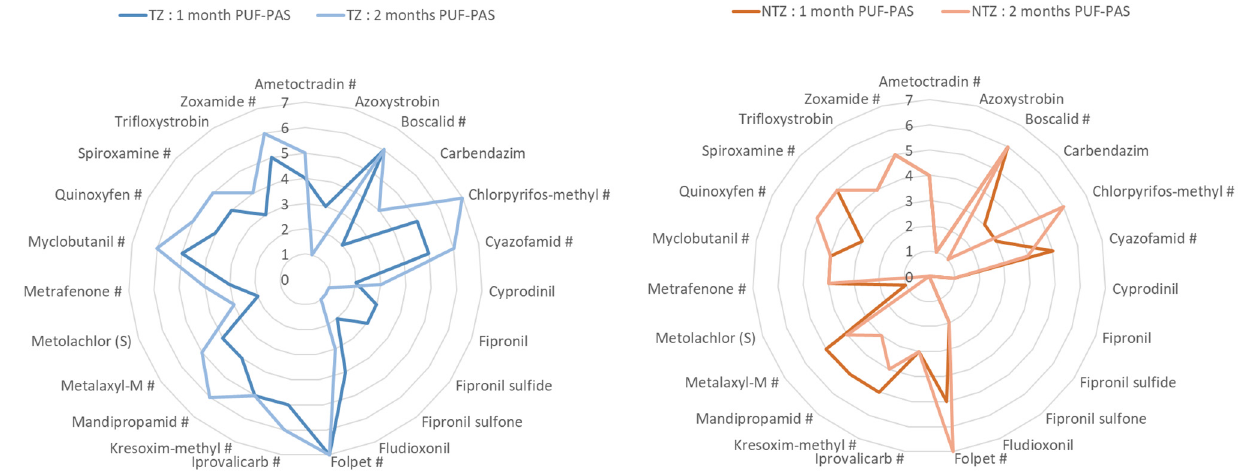
Figure 2. Detection frequencies by the PUF-PAS sampled for a period of one or two months from February to December 2013 in the treated zone (TZ) ( left ) and nontreated zone (NTZ) ( right ). #: Applied on the vineyard plot in 2013.